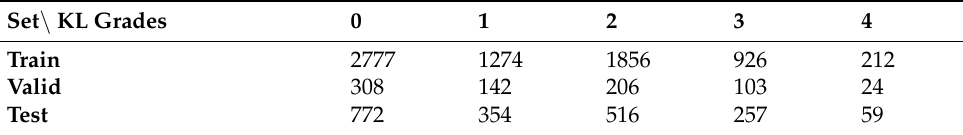
Table 1. KL grades frequency distribution among training, validation, and testing